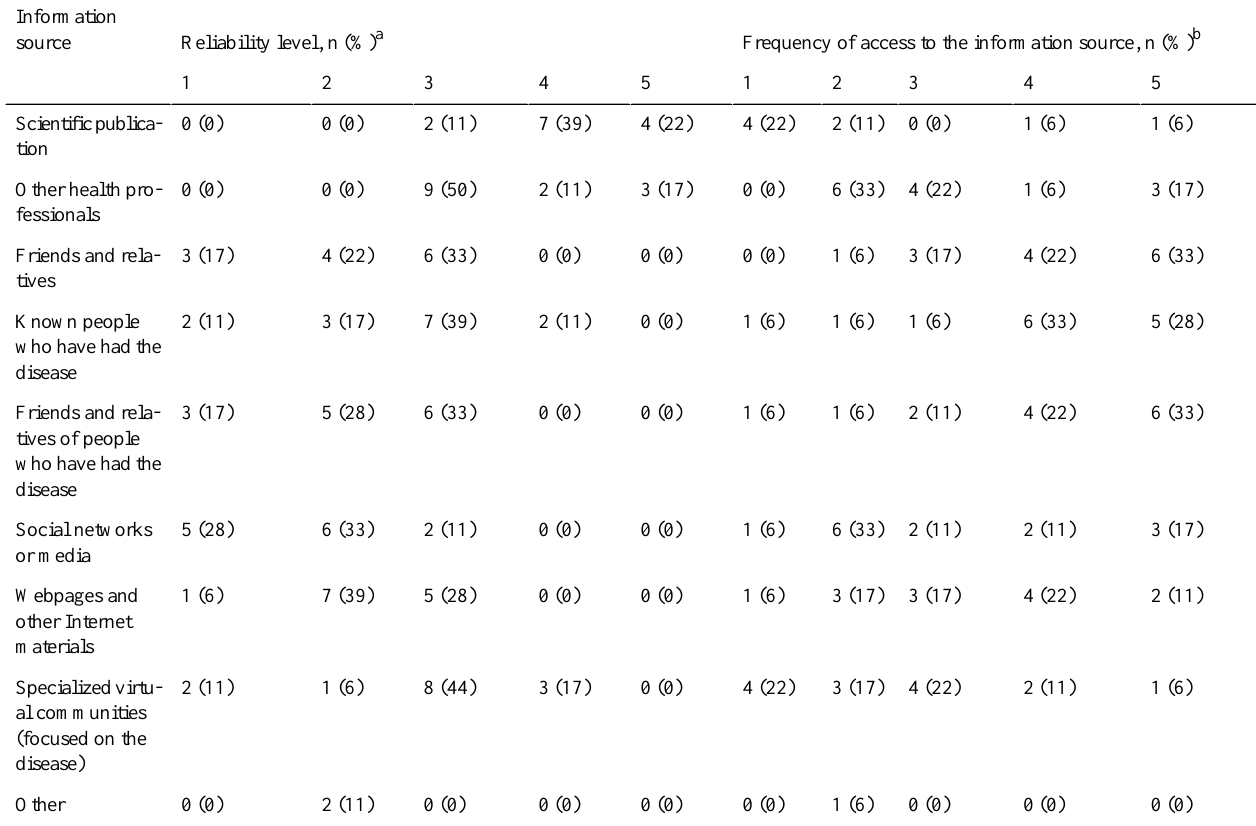
Table 7. Reliability level of information sources according to health care